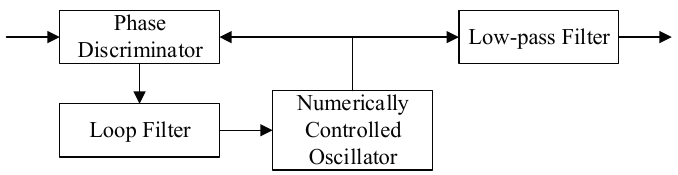
Figure 3. Block diagram of GMSK demodulation in an AIS receiver.